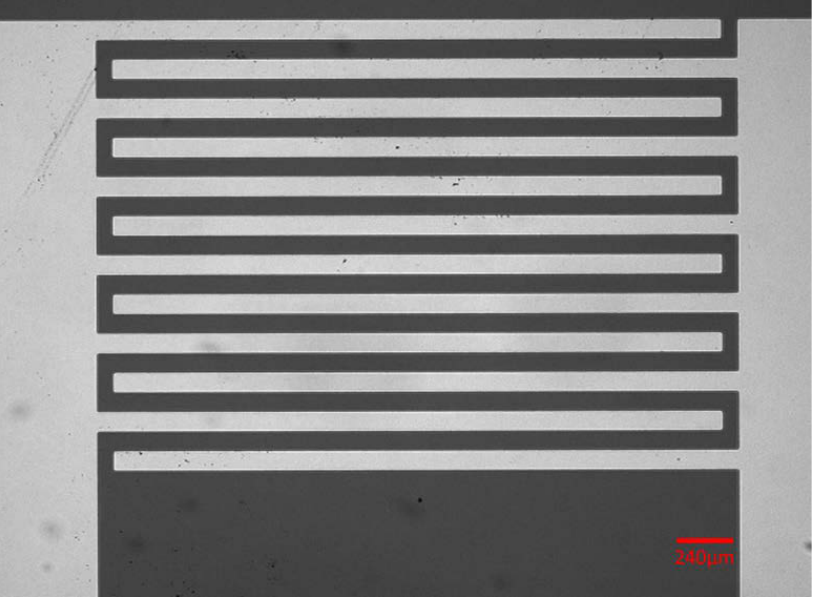
Figure 1. The schematic of the IDEA. The gold electrode fingers (light against the dark background of the substrate) have the spacing between the adjacent fingers of 70 μm.